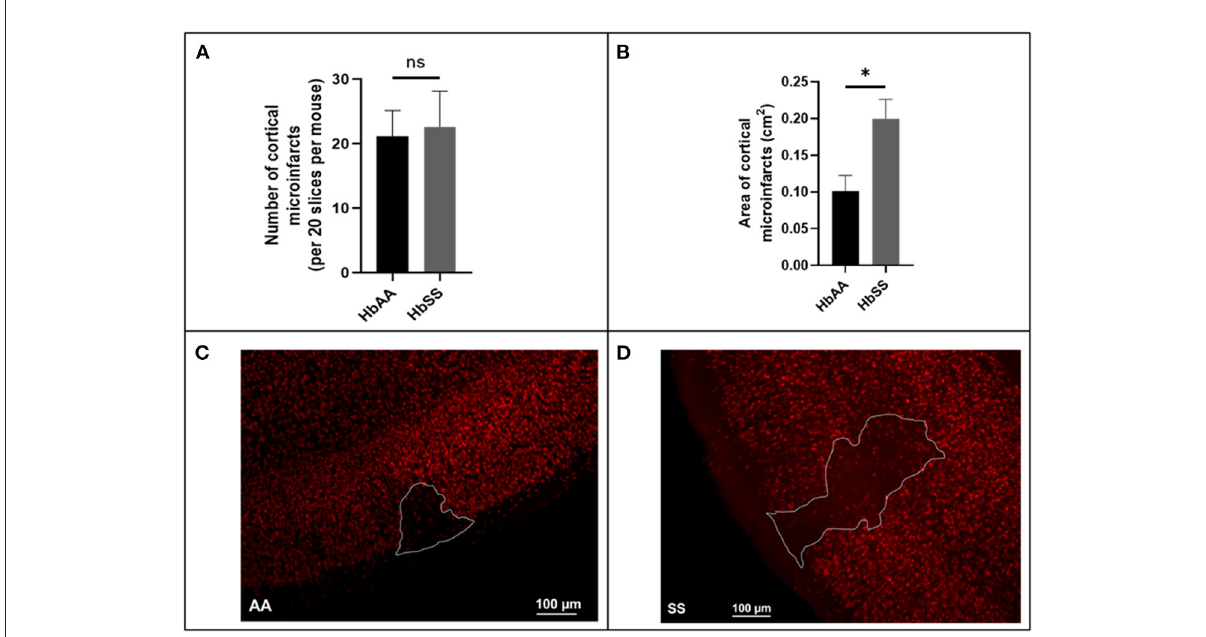
FIGURE4 Baseline microinfarct data from 13-month-old mice. (A) Frequency of cortical infarcts per was not significantly different between HbAA and HbSS. (B) area of cortical infarcts in cm 2 . Error bars are standard error of means (SEM) (AA: n = 5; SS: n = 5). * p < 0.05. (C) Representative image of AA mouse microinfarct area. (D) Representative image of SS mouse microinfarct area. Mean comparisons done using Welch’s corrected t -test.